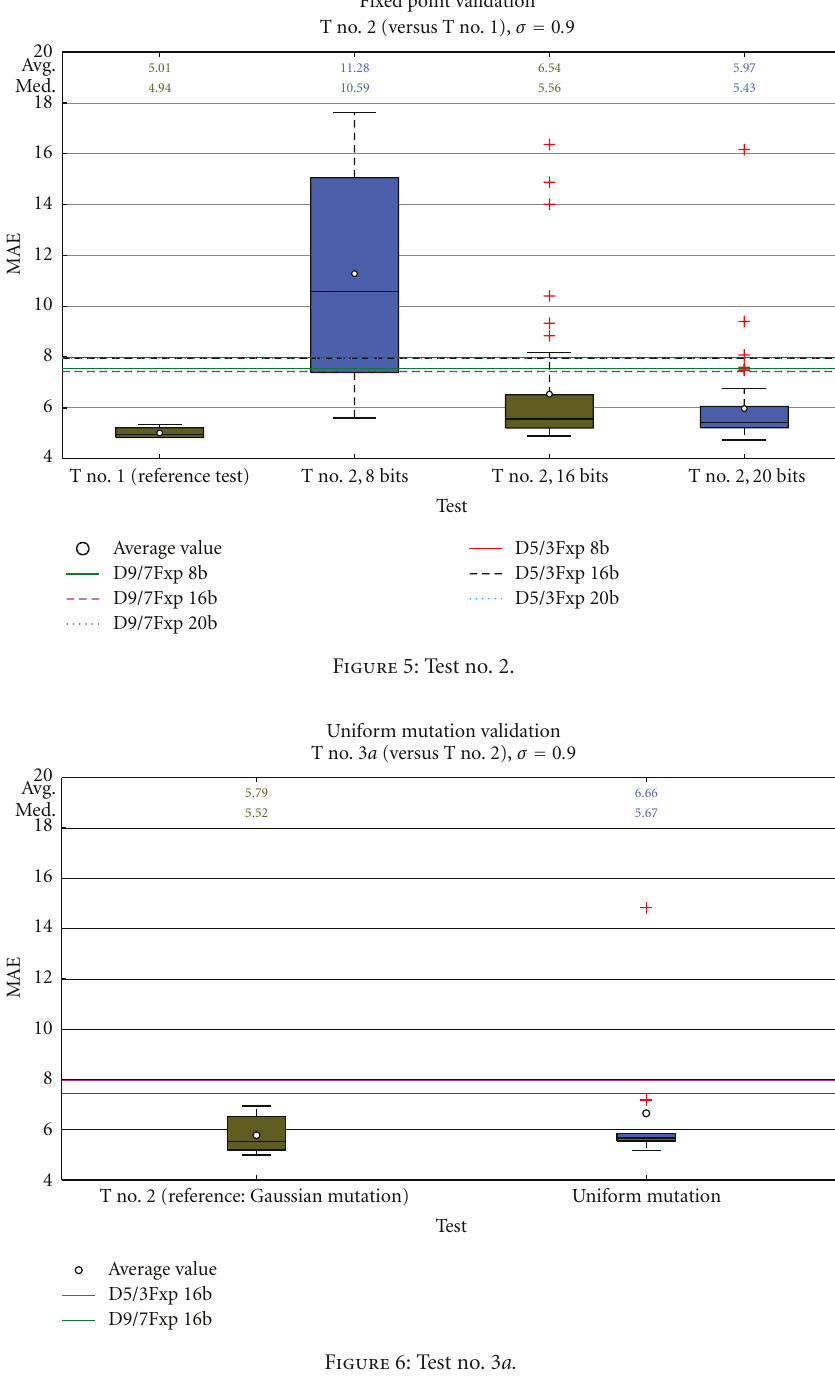
Figure 6: Test no. 3 a.